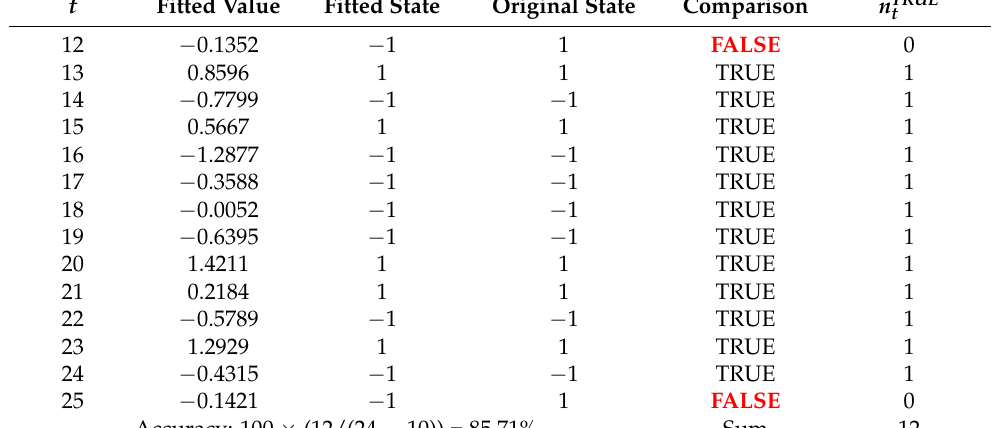
Table 19. Coe ffi cients of AR(10) process for M4 x –the fi rst di ff erence.